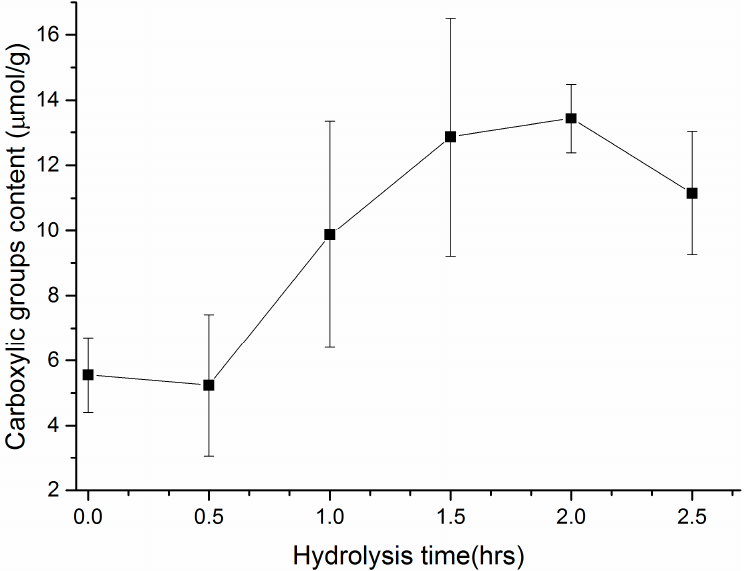
Figure 3. Content of carboxylic groups in hydrolyzed PAN membranes for different treatment times determined by Toluidine blue O (TBO) colorimetric method.